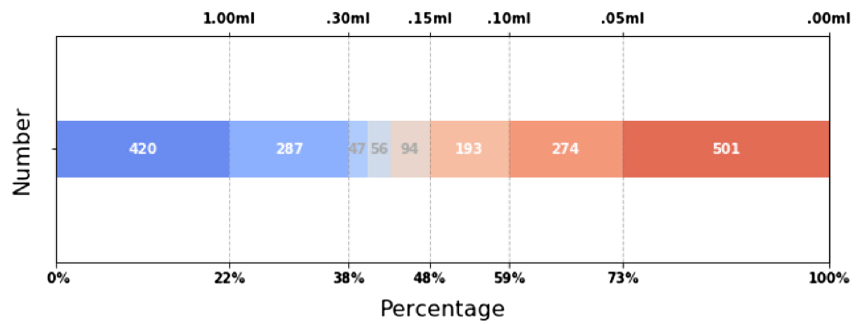
Figure 1. The number and proportion of each tumor volume